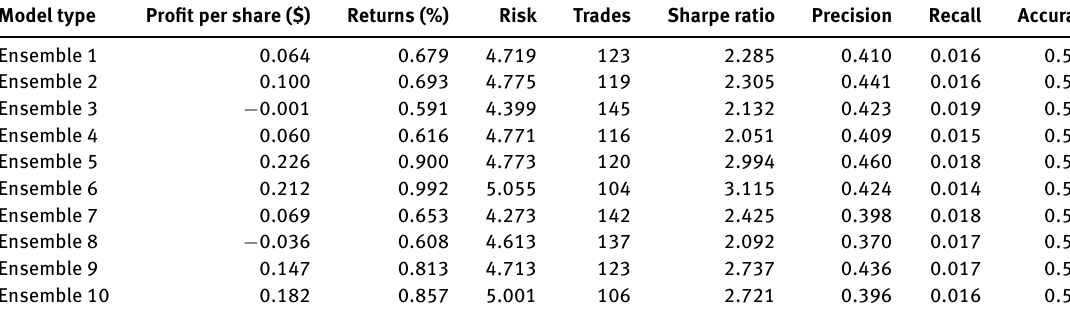
Table 12: 60-Min Ensemble of Regression Models Metrics on Validation Set. Model type